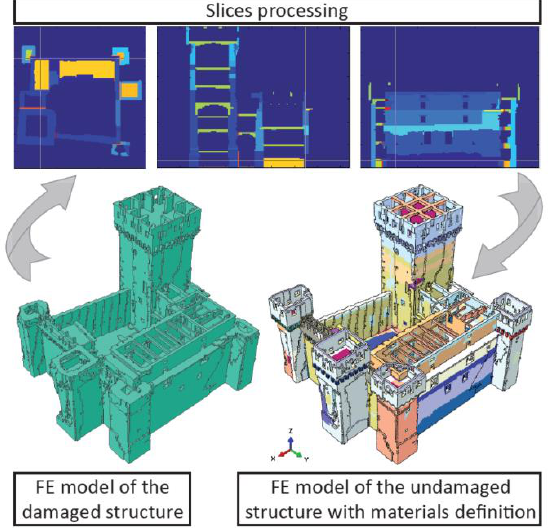
Figure 1. FE models generated from the point cloud: an example of slices processing to obtain the model of the undamaged structure, as well as the material